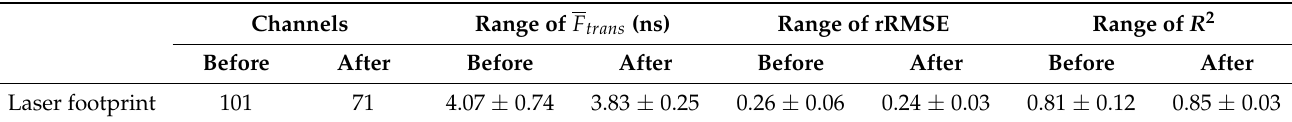
Table 2. Comparison of initial channel selection results considering transmitter